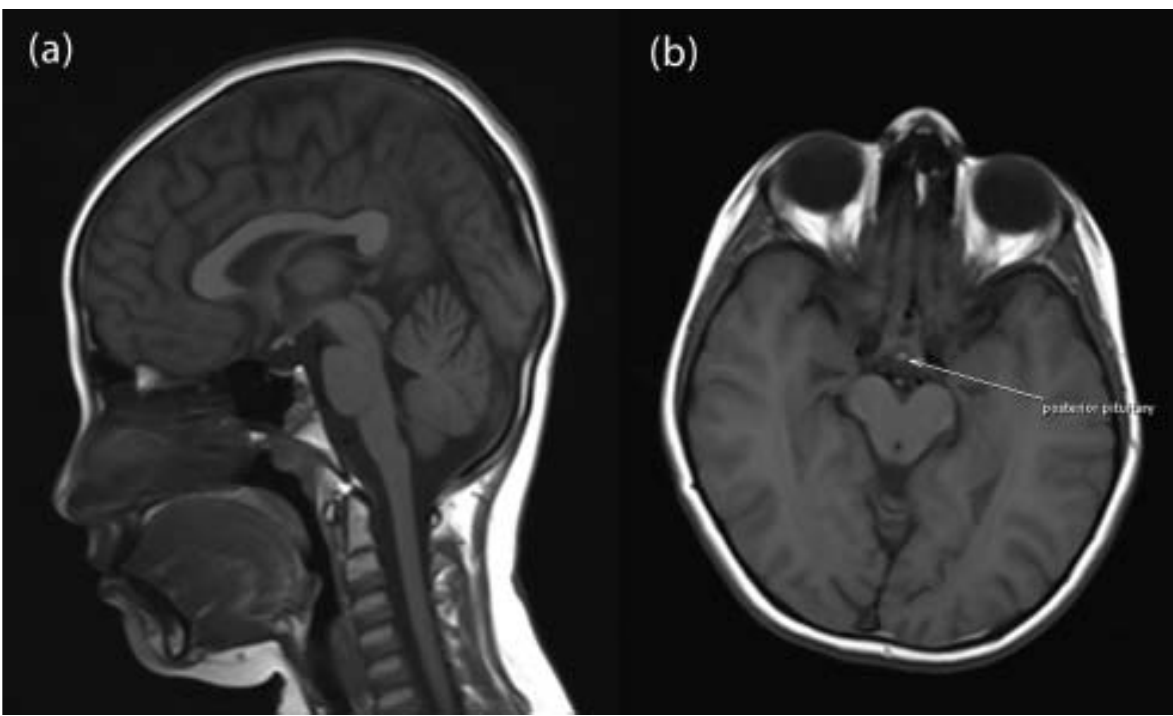
Figure 1. MRI brain (a) sagittal and (b) axial images showing an absent anterior pituitary and ectopic posterior pituitary located in the region of the hypothalamus with absent pituitary